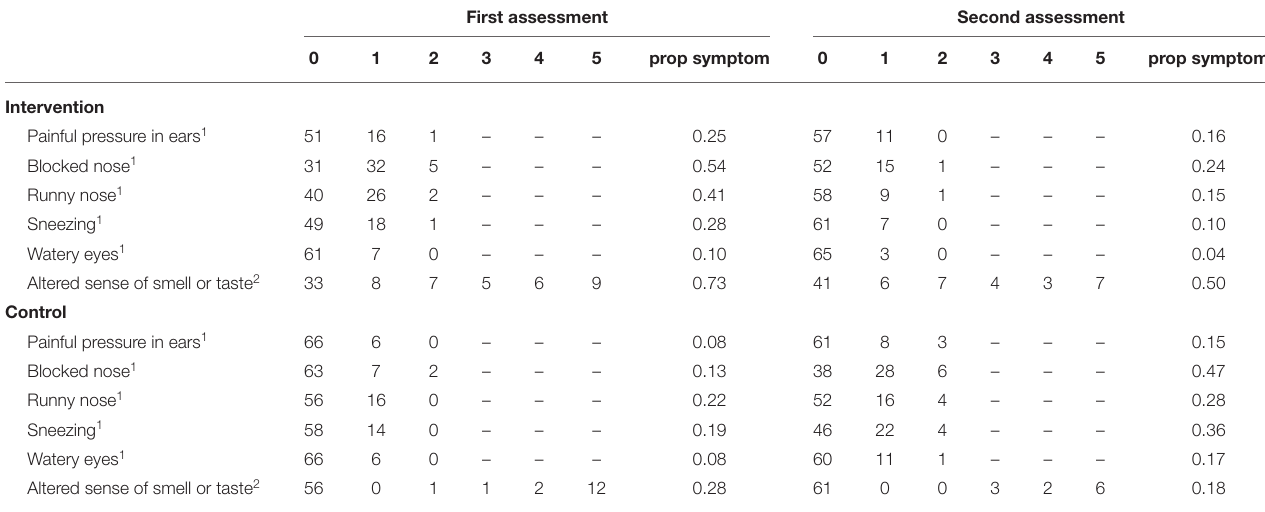
TABLE 1 | Reported symptom